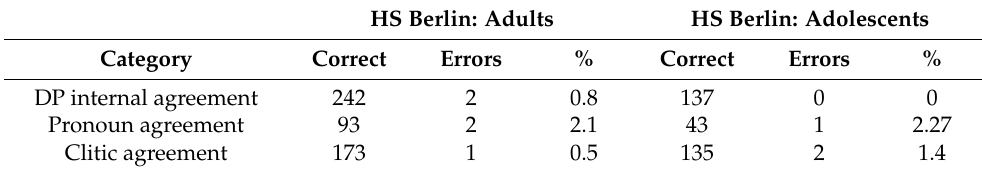
Table 7. Preliminary Results. German HSs (DE), illustration of percentage of errors. HS Berlin: